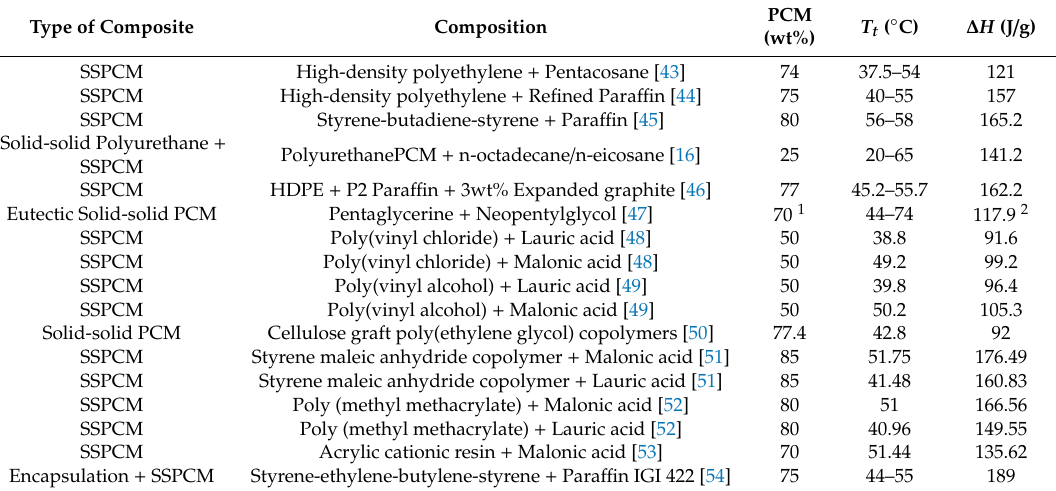
Table 4. Summary of some reported SSPCMs with a phase transition around 40 ◦ C.